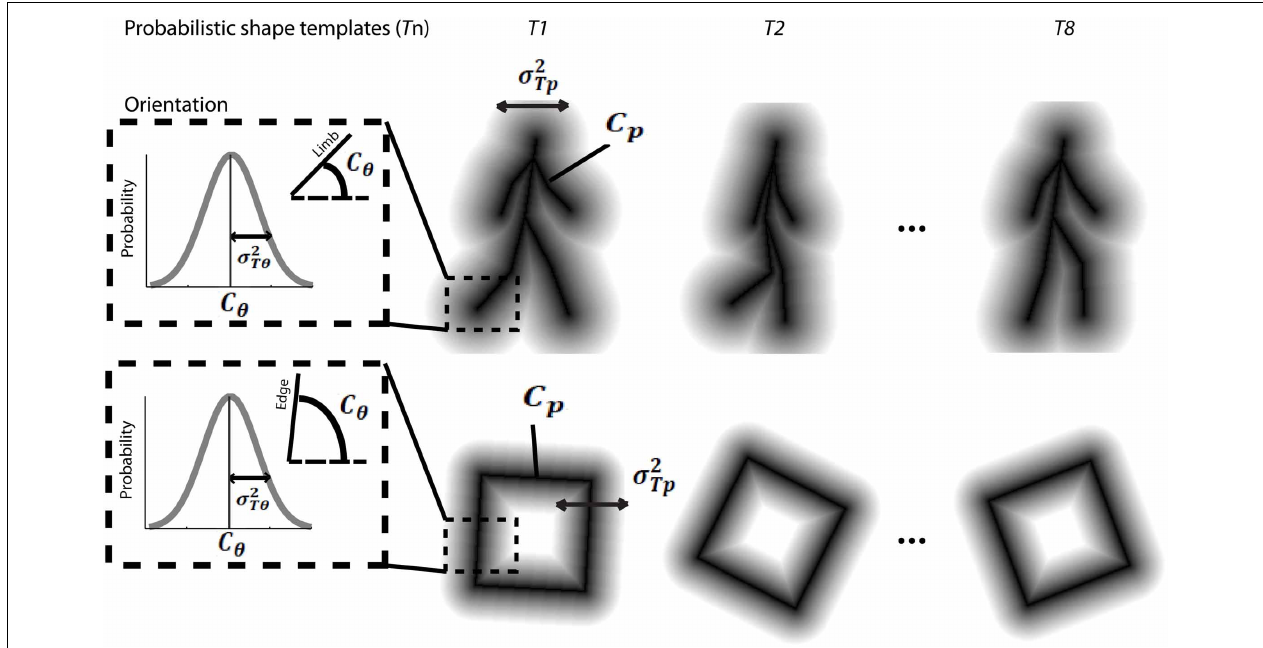
FIGURE 5 | Schematic depiction of probabilistic shape templates for biological walking stimuli (top), and rotating square stimuli (bottom). The dashed square box highlights the probabilistic